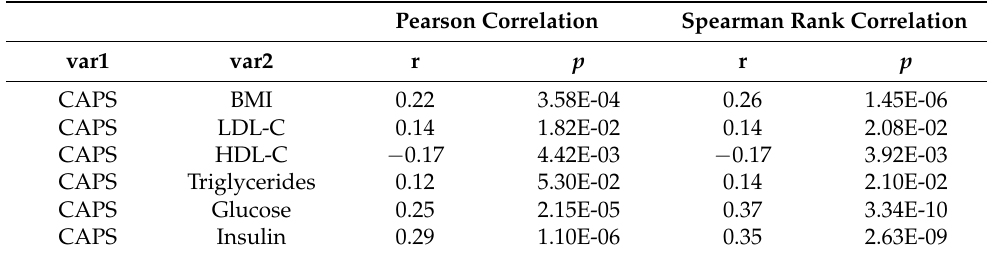
Table 1. Correlation estimates between CAPS score and metabolic traits in the SBC dataset.